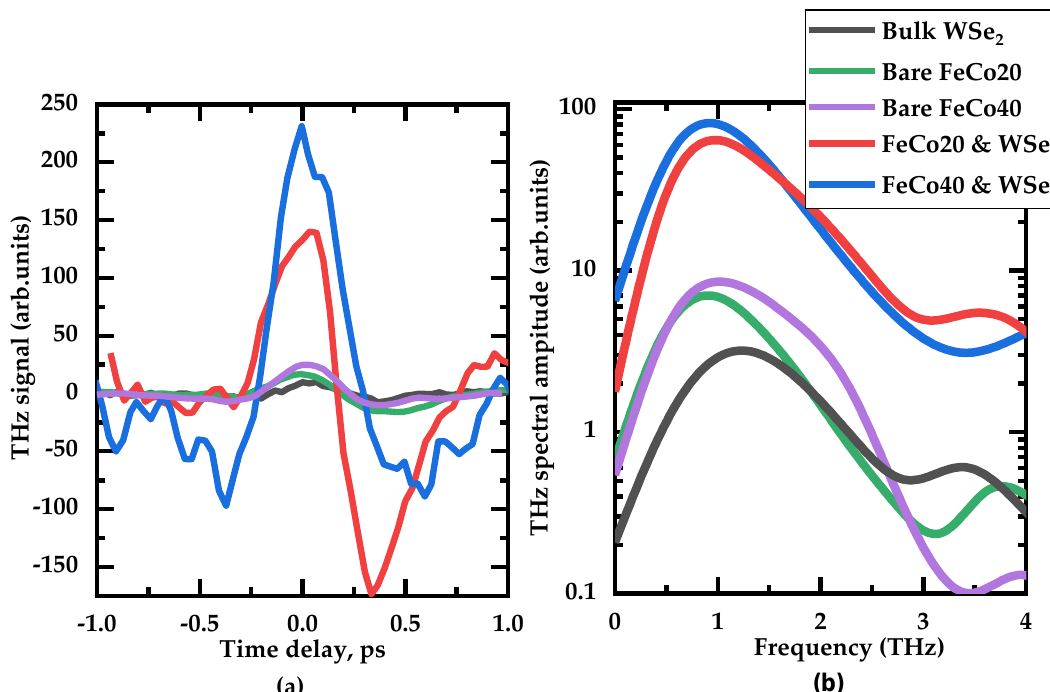
Figure 3. ( a ) THz time − domain signal generated by various structures and ( b ) correspondent spec- tra.